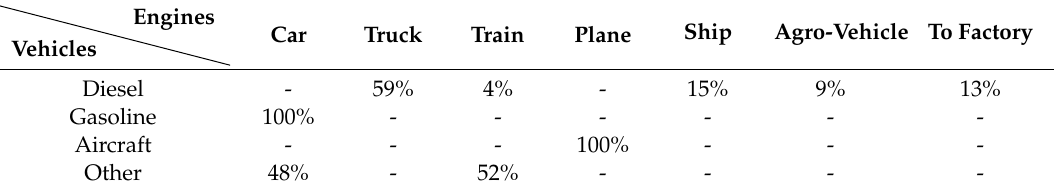
Table A3. The shares of engines energy flows to di ff erent vehicles of China in 2015.